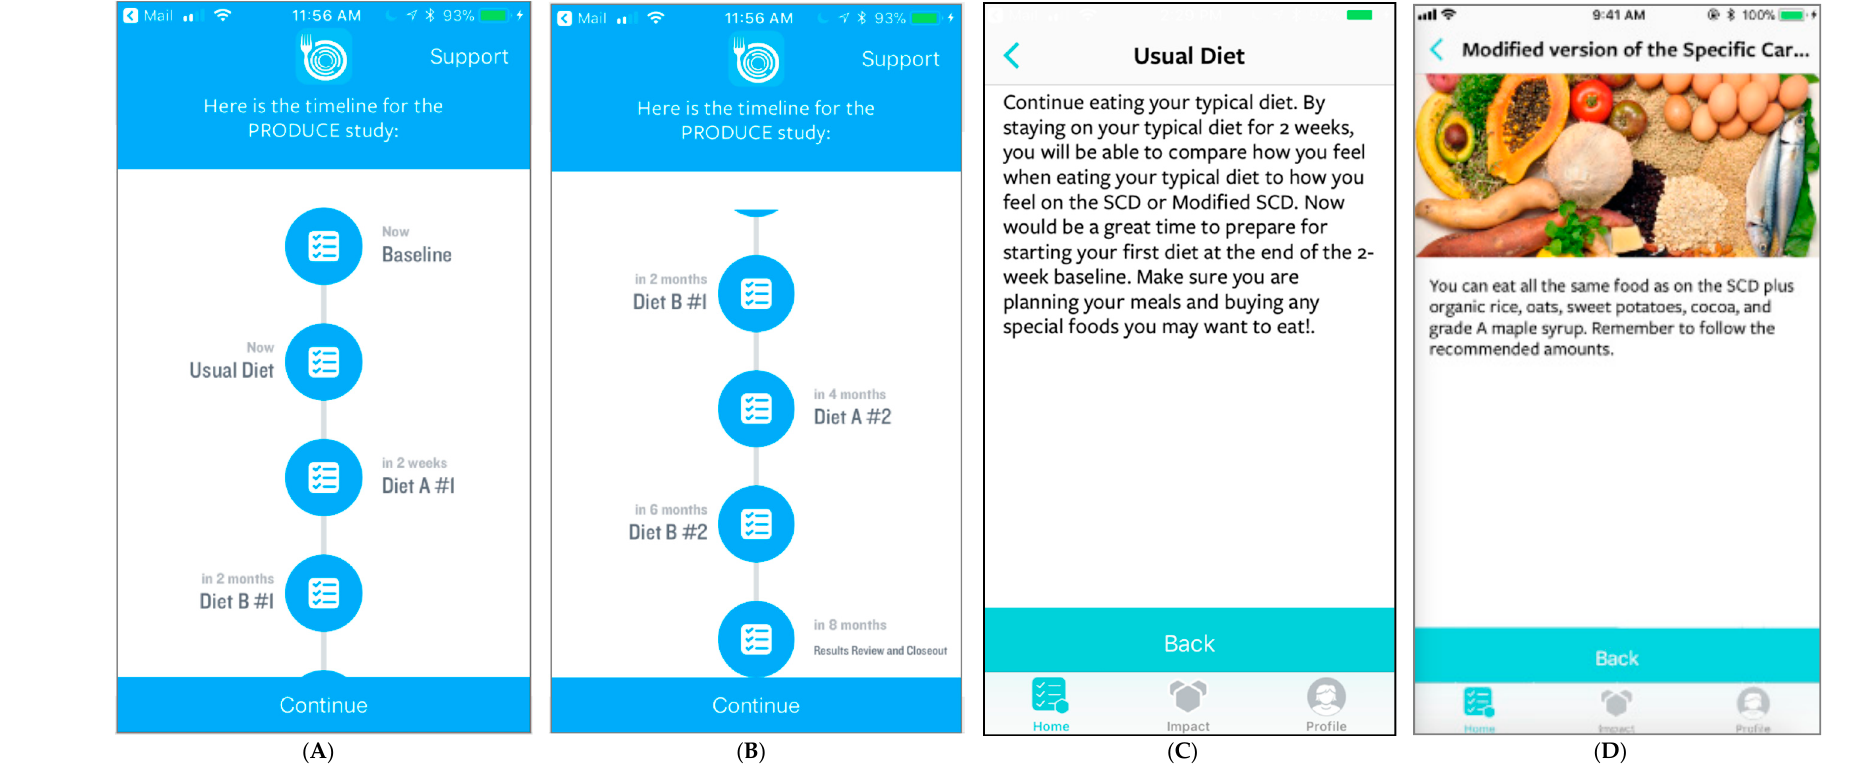
Figure 2. Screen shots of study timeline, including start ( A ) through completion ( B ) and information on usual diet ( C ) and the modified specific carbohydrate diet ( D ), as viewed through the participant mobile application.